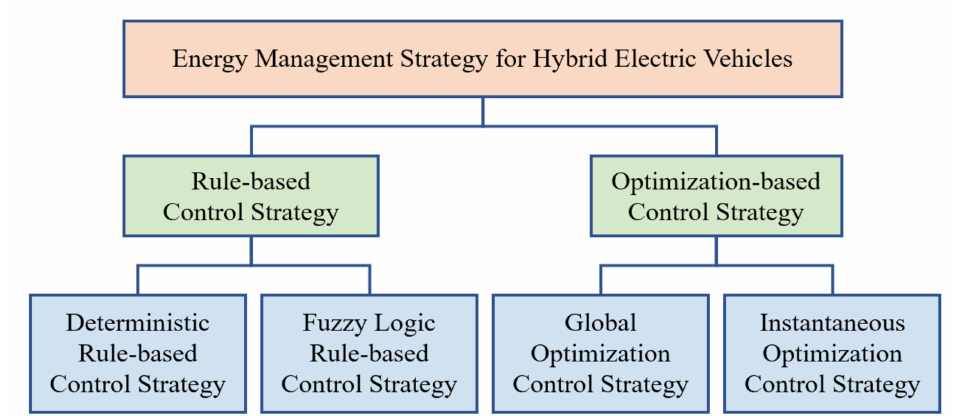
Figure 1. Classification of energy management strategies (EMSs) for hybrid electric vehicles